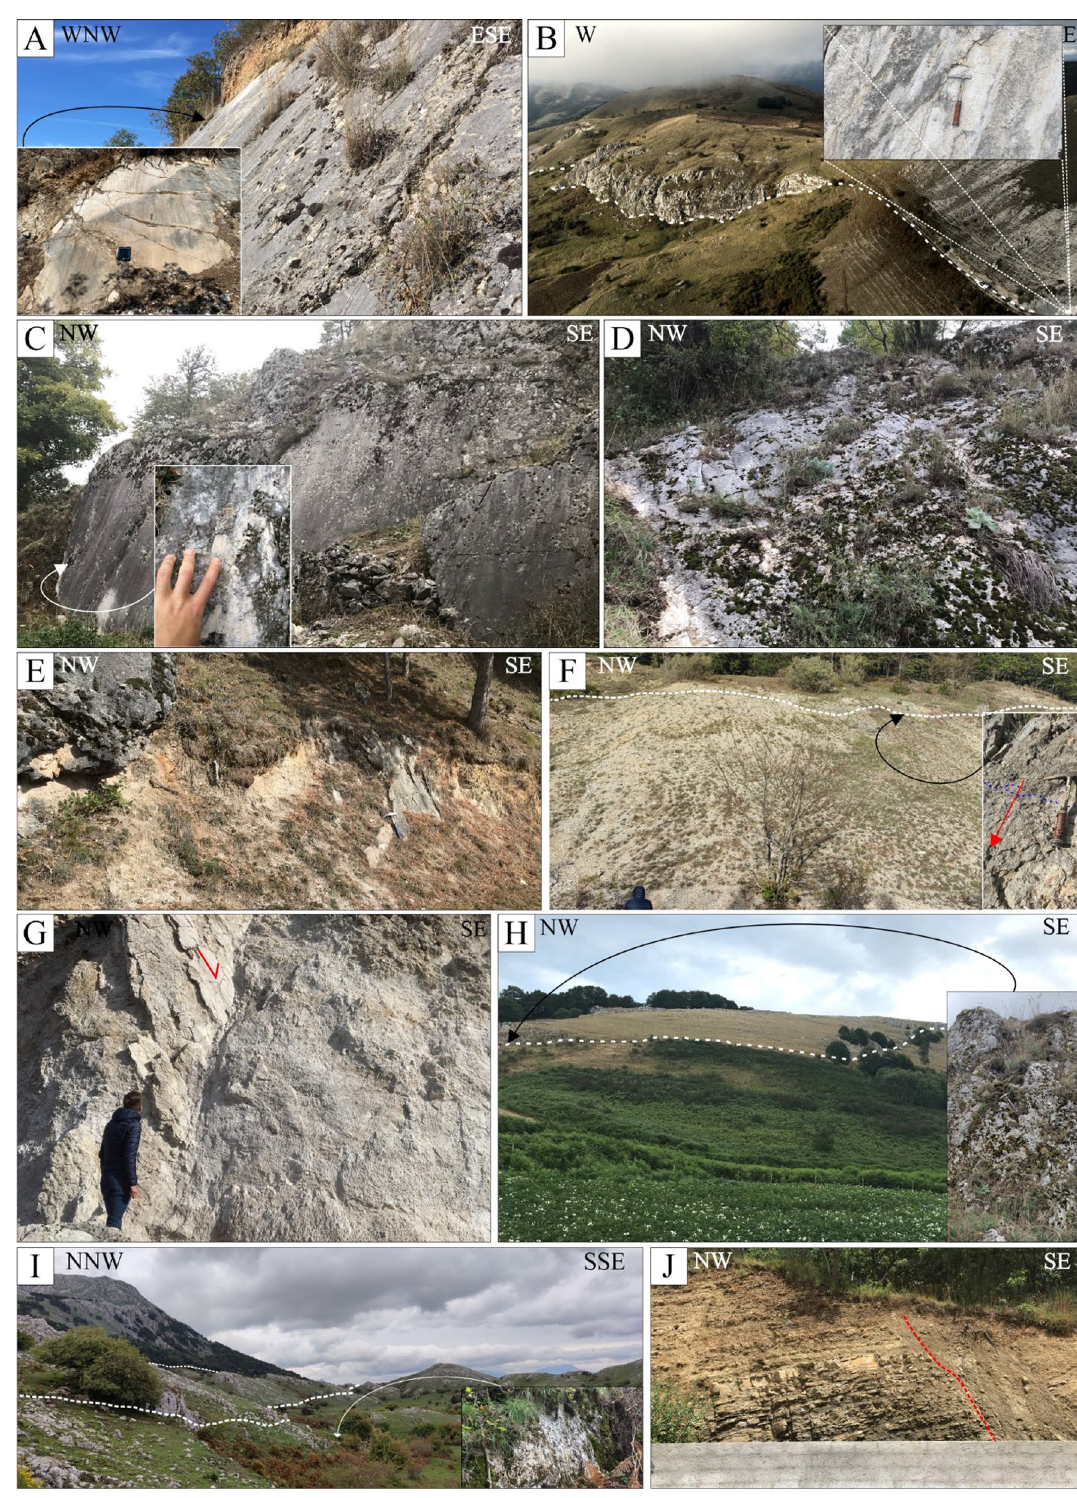
Figure 2. Photographic documentation of faulting along the fault alignments of Fig. 1A (see Supplementary Data 1 for a complete geo-referenced photographic documentation from the fieldwork). (A) Striated fault plane near Polla, looking NNE. (B) Panoramic view (looking north) of the Timpe fault 46 with detail of slickenlines on the polished slip surface. (C) , (D), Striated fault planes along the southern prosecution of the Timpe fault, and ( E ) on the en-échelon strand developing SE of Atena Lucana. ( E) Displaced deposits close to Marsicovetere (F) fault plane cropping out close to Marsicovetere and detail of normal striations, looking NE. (G) Striated normal fault plane close to Marsicovetere, looking north. (H) Fault scarp (white dotted line) and associated striated breccia cropping out at the edge of a small intramountain plane, NW of Paterno, looking NE. (I) boundary fault of a small basin, NE of Marsicovetere, looking WNW. (J) Displaced beds of the Gorgoglione Flysch along a SW-dipping normal fault between the Montemurro and Armento villages, looking